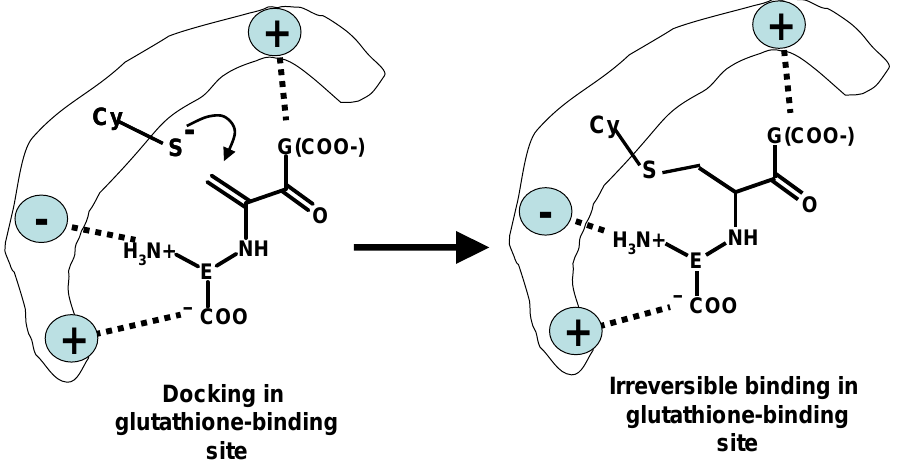
Scheme 9. Outline of the mechanism for enzyme inactivation by dehydro-alanine (acrylate)